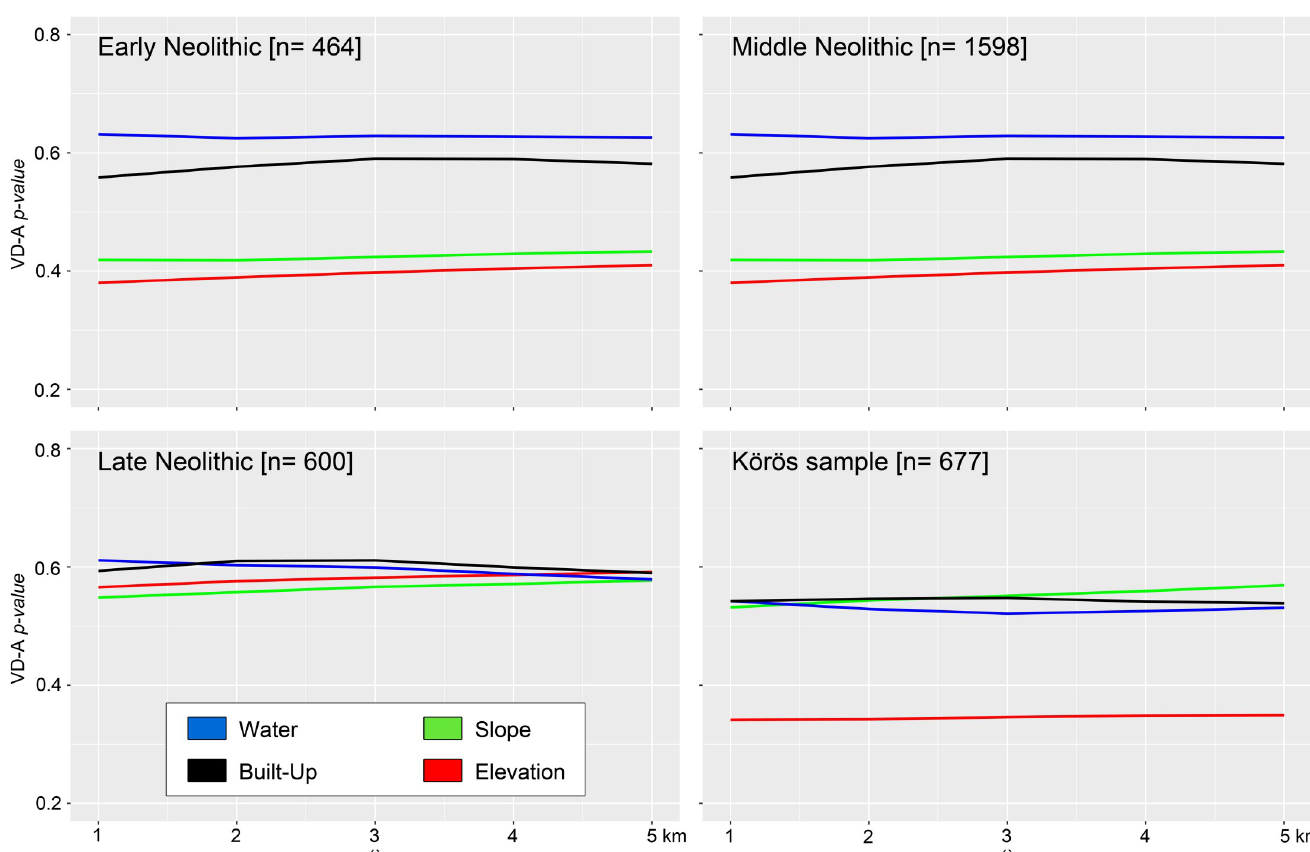
Fig 10. Additional environmental and modern explanatory covariate. VD-A p-values of the hydrologic composite (water), slope and elevation as well as the modern built-up within 1 to 5 km distance around EN, MN, LN sites, and the Ko¨ro¨s comparison sample.